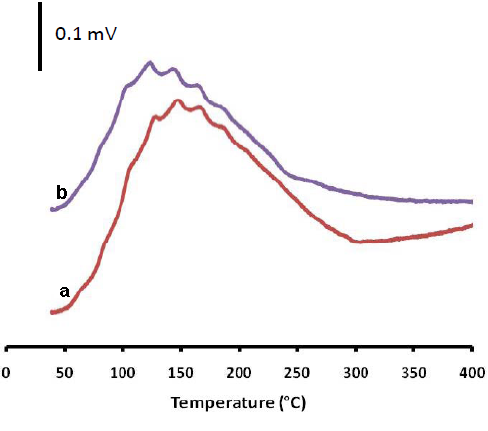
-TPD curves of (a) nano-SiO 3